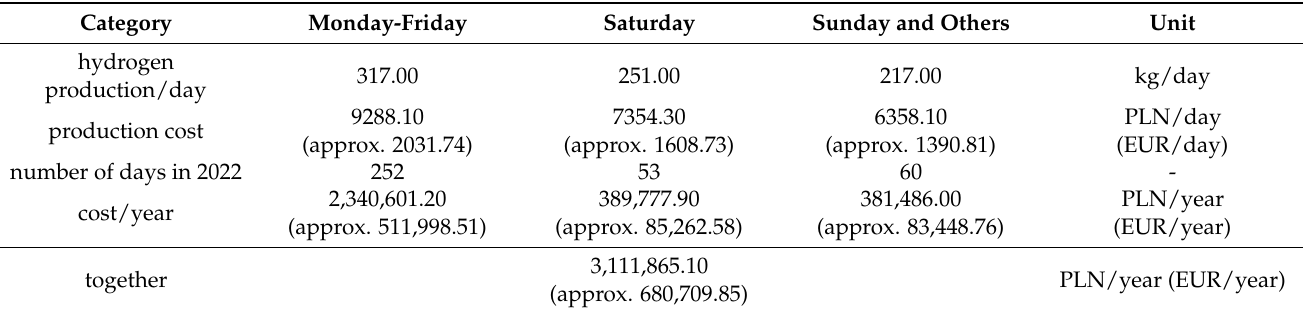
Table 3. Results of calculations of hydrogen generation costs to ensure scheduled bus journeys on weekdays, Saturdays and Sundays with holidays for